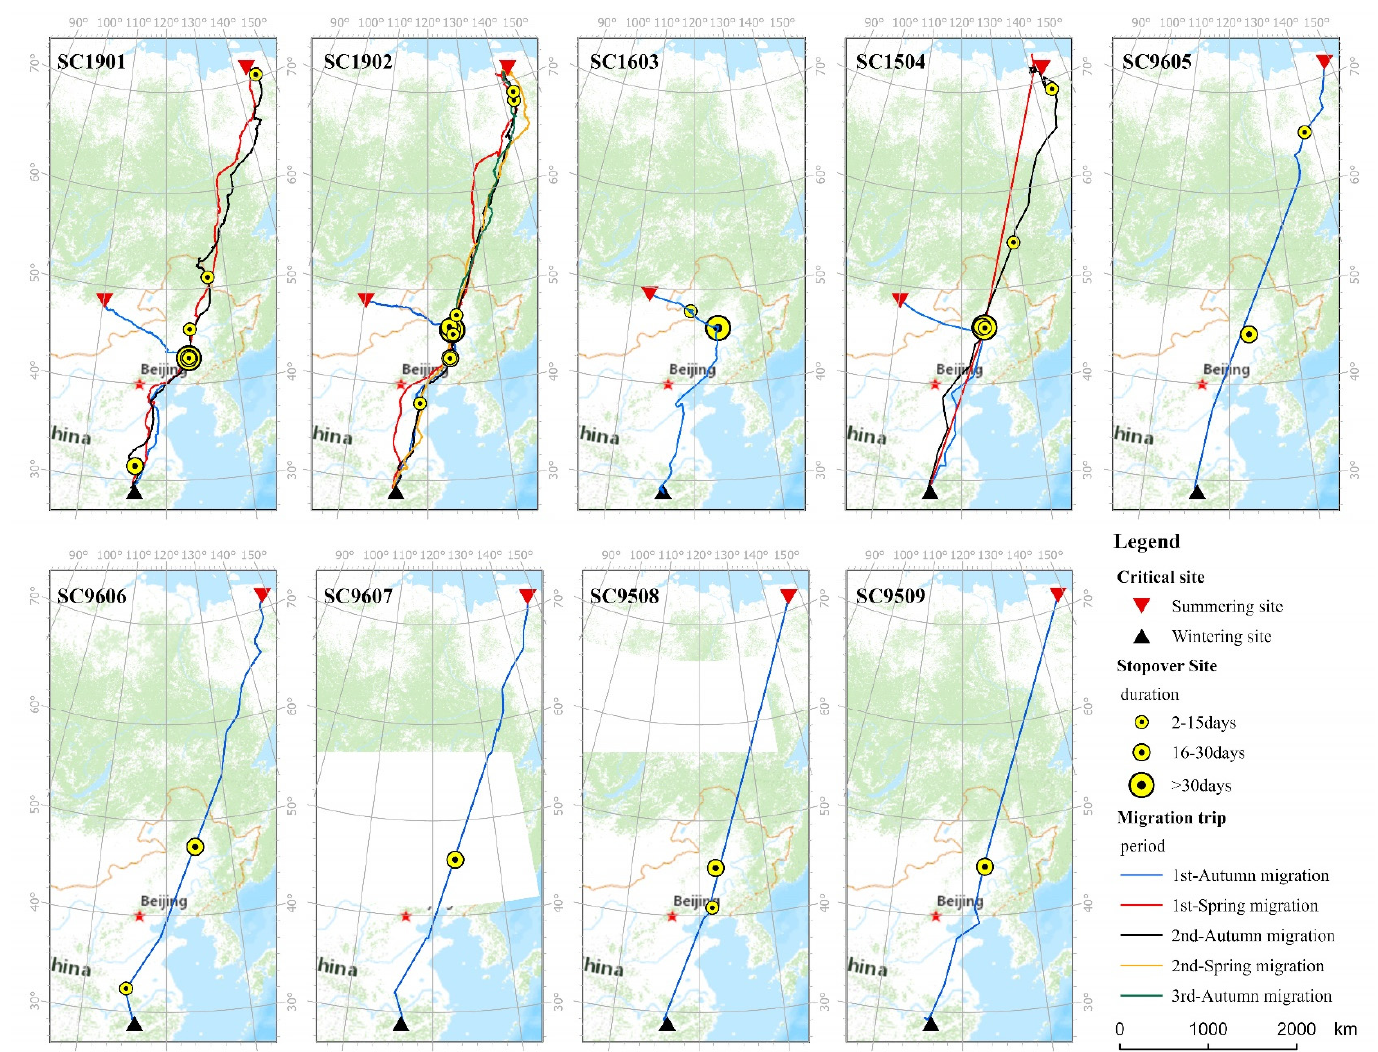
= Figure 2. Migration routes and critical sites of nine Siberian cranes ( Leucogeranus leucogeranus ).